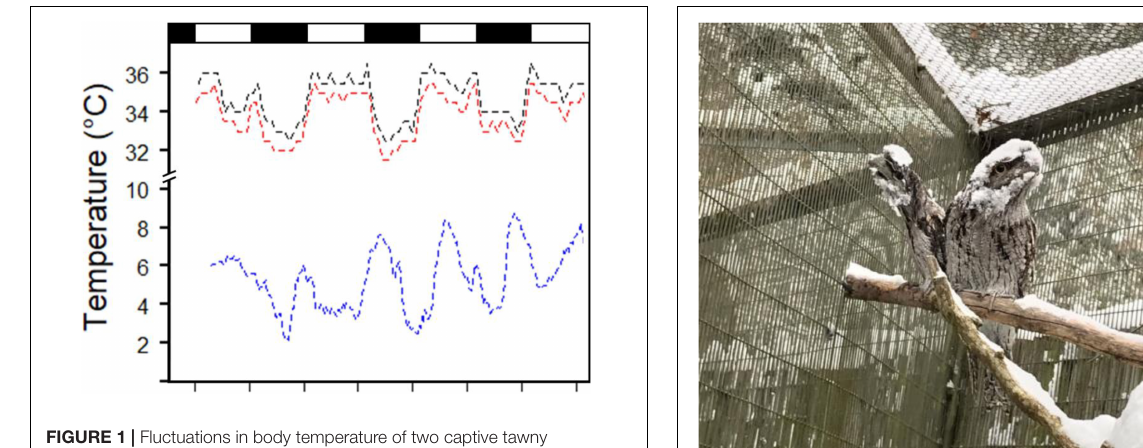
FIGURE 1 | Fluctuations in body temperature of two captive tawny frogmouths ( Podargus strigoides ) from Woodland Park Zoo in Seattle, Washington (red and black dashed lines, measured by an internal transmitter) and in air temperature (blue dashed lines solid line) over 4 days in December. Note the break in y-axis. Black rectangles represent night.